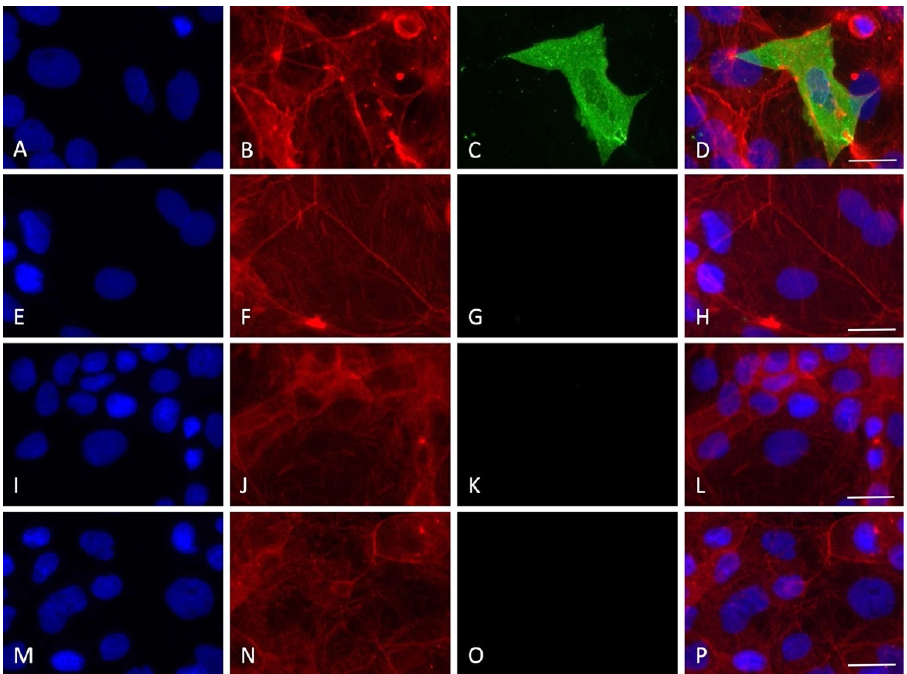
Figure 7. Immunofluorescence staining for nucleocapsid SARS ‐ CoV ‐ 2 protein with the experimental protocol employing 5 min of viral absorption (60× magnification, scale bar 30 micron). The fluorescence for nucleus (blue), F ‐ actin cytoskeleton (red), nucleocapsid protein of SARS ‐ CoV ‐ 2 (green) and the merge of the three channels are displayed. ( A – D ) MOI 0.1; ( E – H ) MOI 0.01; ( I – L ) MOI 0.001; ( M – P ) MOI 0.0001.